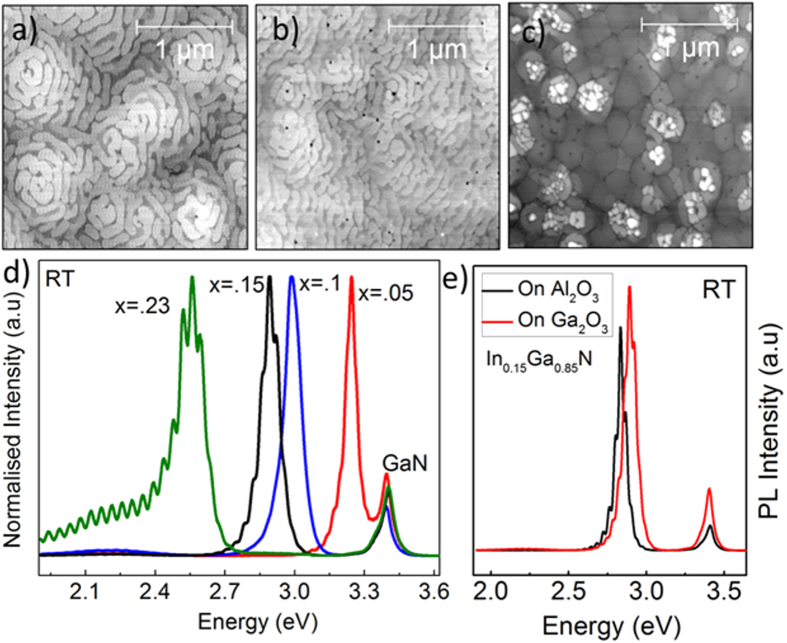
The 2.5 × 2.5-μm AFM images of the InxGa1−xN epilayers for different. In concentrations (a) x = 0.1, (b) 0.15, and (c) 0.23. (d) The RT PL spectra of InxGa1−xN films; spectra show oscillations due to interference at interfaces. (e) PL spectra comparison between In0.15Ga0.85N grown on Ga2O3 and Al2O3.